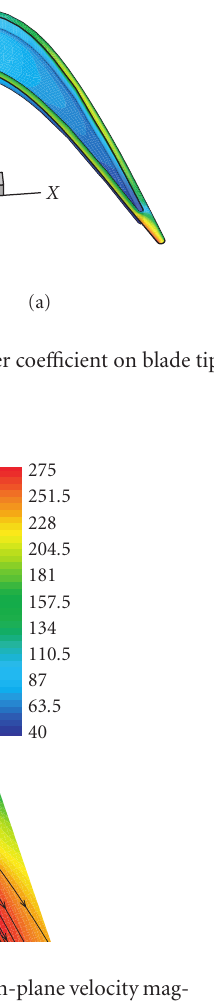
Figure 12: Streamlines superimposed on the in-plane velocity mag- nitude (m/s) contours at the mid-height of the tip gap for baseline squealer tip.